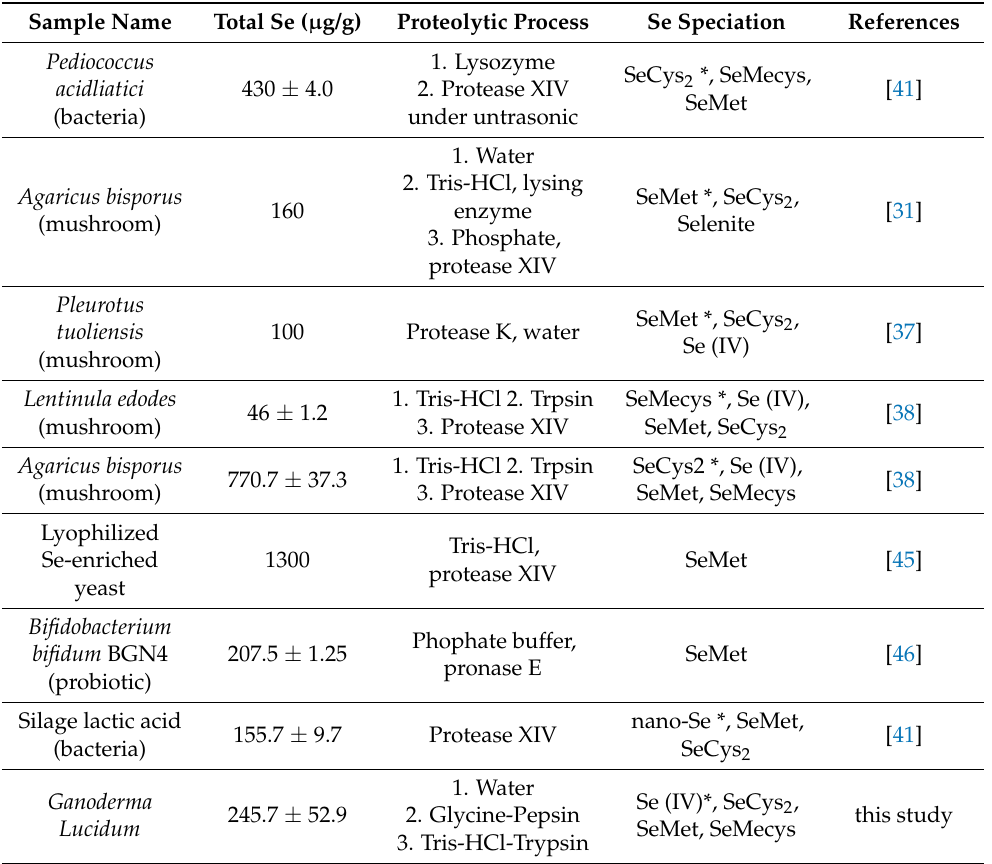
Table 2. Methods of Se isolation and speciation of Se in various